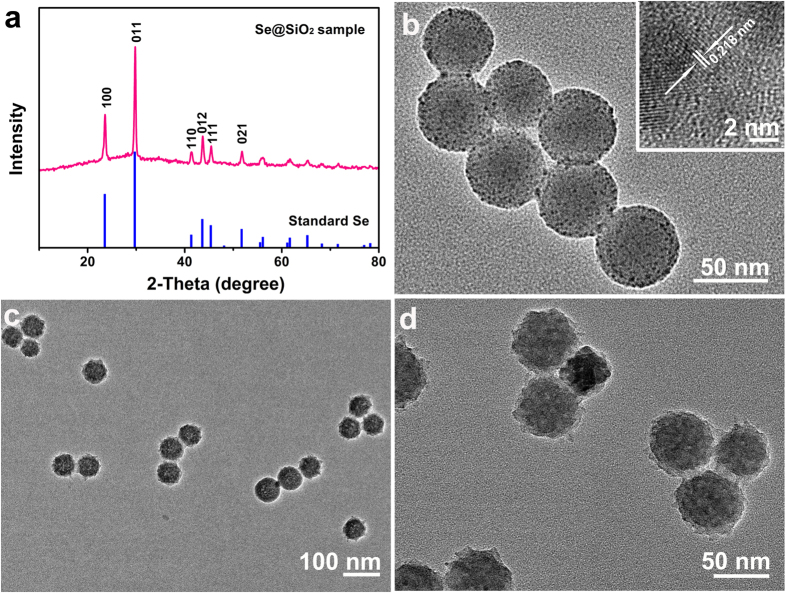
The characterization of the Se@SiO2 nanocomposites: (a) XRD pattern of the Se@SiO2 nanocomposites and the standard hexagonal phase of Se (JCPDS card no: 65-1876). (b) TEM image of as-prepared Se@SiO2 nanocomposites (inset: HRTEM of a Se@SiO2 nanocomposite). (c) Low magnification and (d) high magnification of the porous Se@SiO2 nanocomposites.